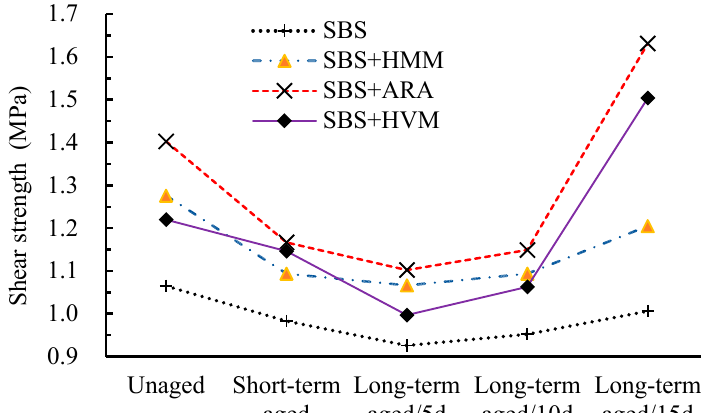
Figure 5. UPT Figure 5. UPT results.